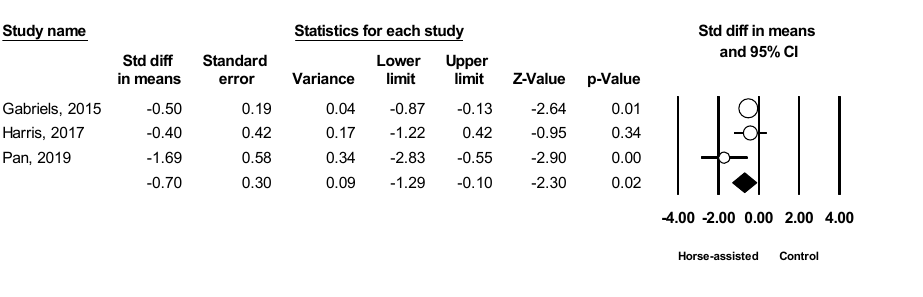
Figure 8. Forest plot showing the effects of horse-assisted therapy vs. control on lethargy [44–46].